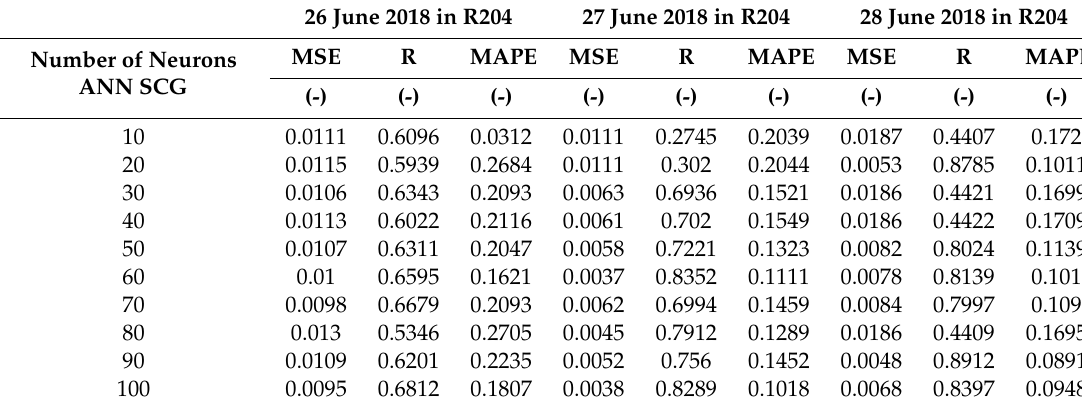
Table 6. Learned ANN SCG from 25 June 2018 in R203 (with T in, rH in and an FBG sensor for PPM) and prediction with cross-validation for 26 June 2018 in R204 (with T in, rH in and an FBG sensor for PPM), 27 June 2018 in R204 (with T in, rH in and an FBG sensor for PPM), 28 June 2018 in R204 (with T in, rH in and an FBG sensor for